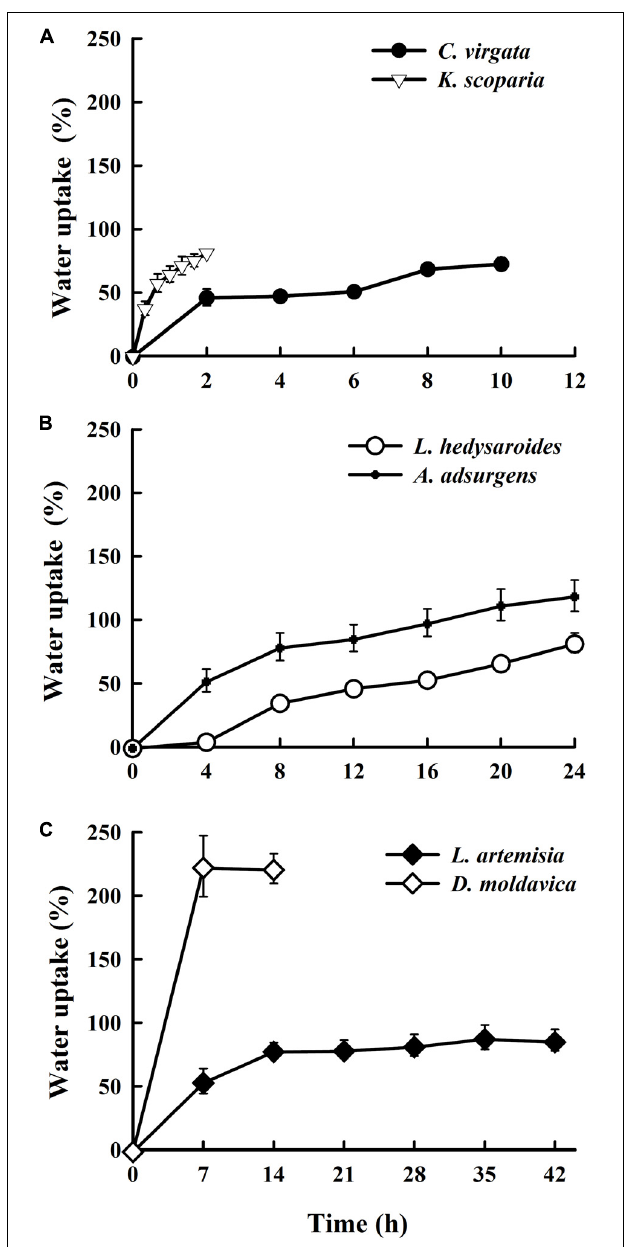
FIGURE 1 | Water uptake (%) of Chloris virgata , Kochia scoparia (A) , Lespedeza hedysaroides , Astragalus adsurgens (B) , Leonurus artemisia, and Dracocephalum moldavica (C) seeds during imbibition at 25 ◦